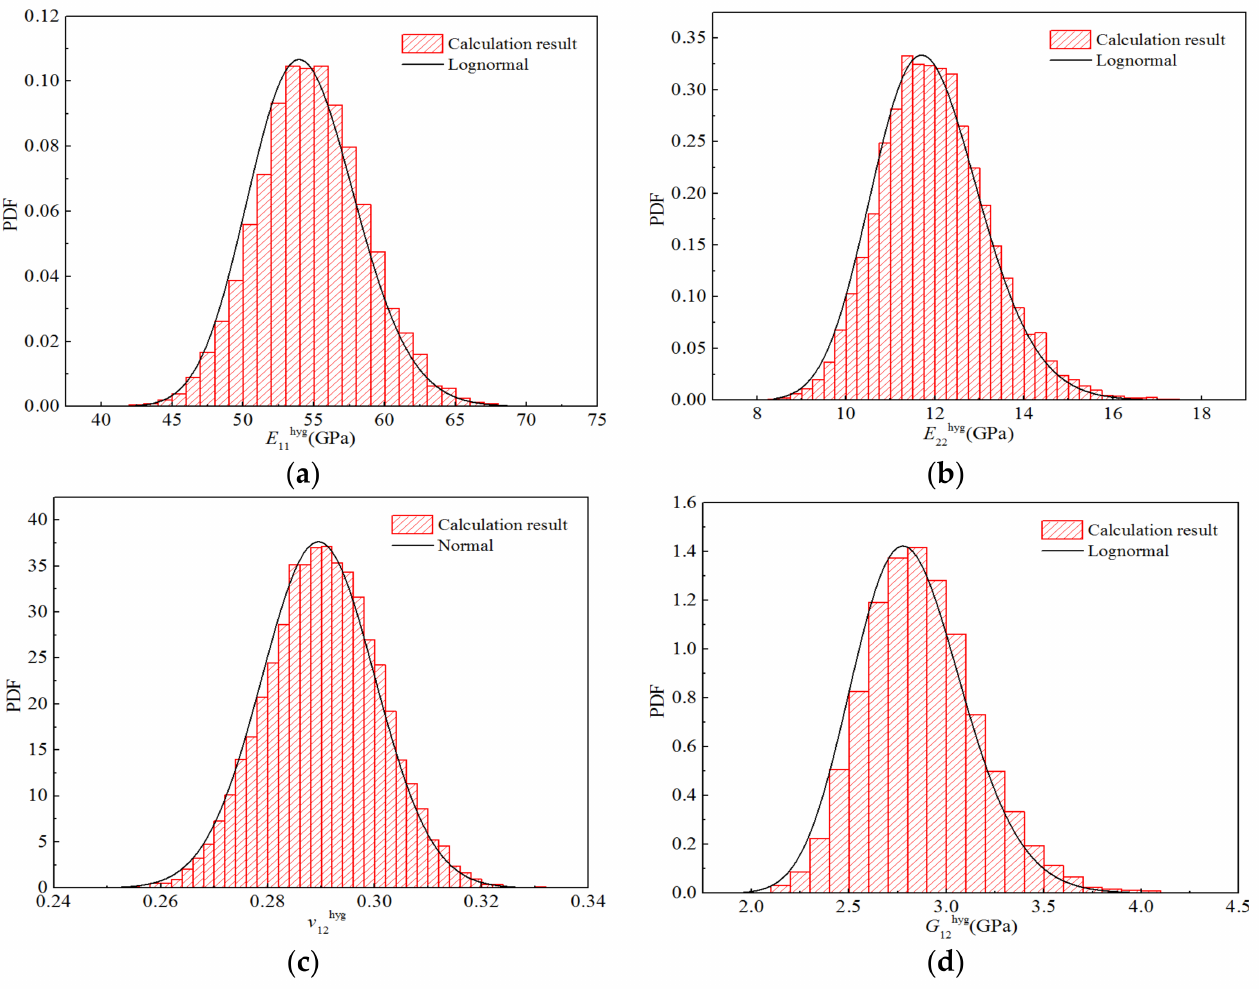
Figure 22. Probability distribution diagrams for the stiffness properties of H-GFRPs under the ETW condition. ( a ) E 11 , ( b ) E 22, ( c ) v 12 , ( d ) G 12 .